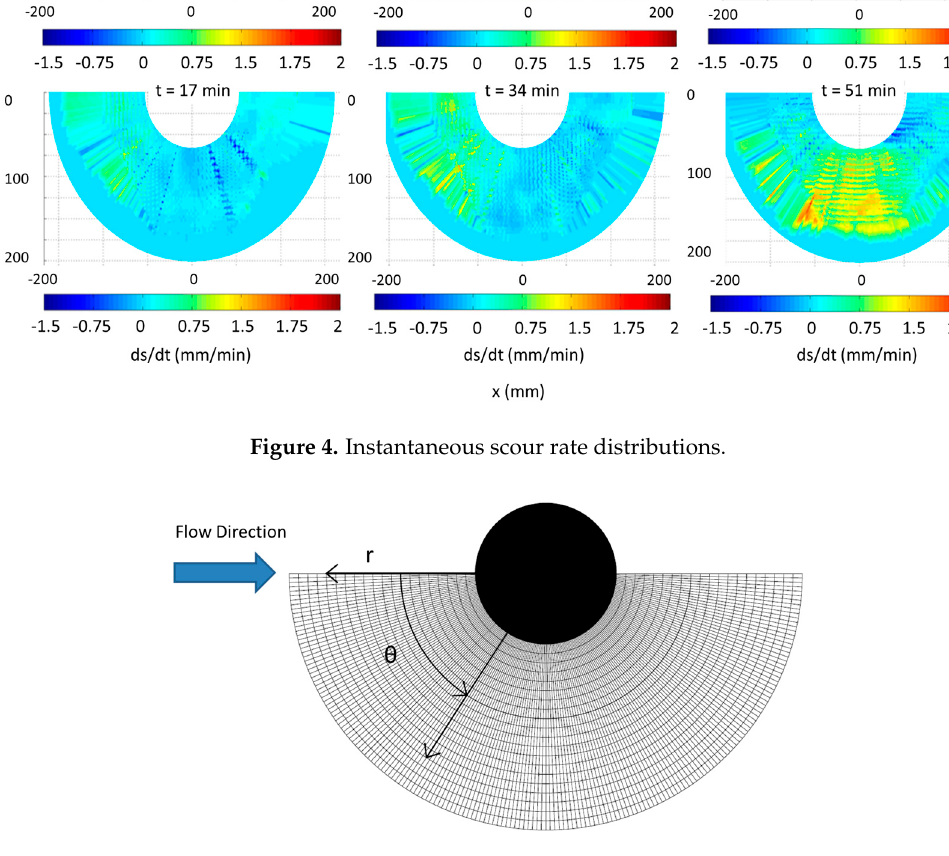
Figure 5. The cylindrical grid that was used for the statistical analysis of the scour hole’s morphology. r: radial distance from the surface of the pier; θ : angle of the plane around the cylinder.